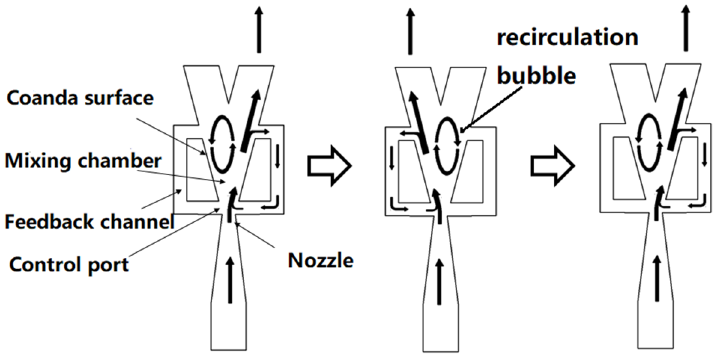
Figure 1. Working mechanism of wall-attached fluidic oscillator.